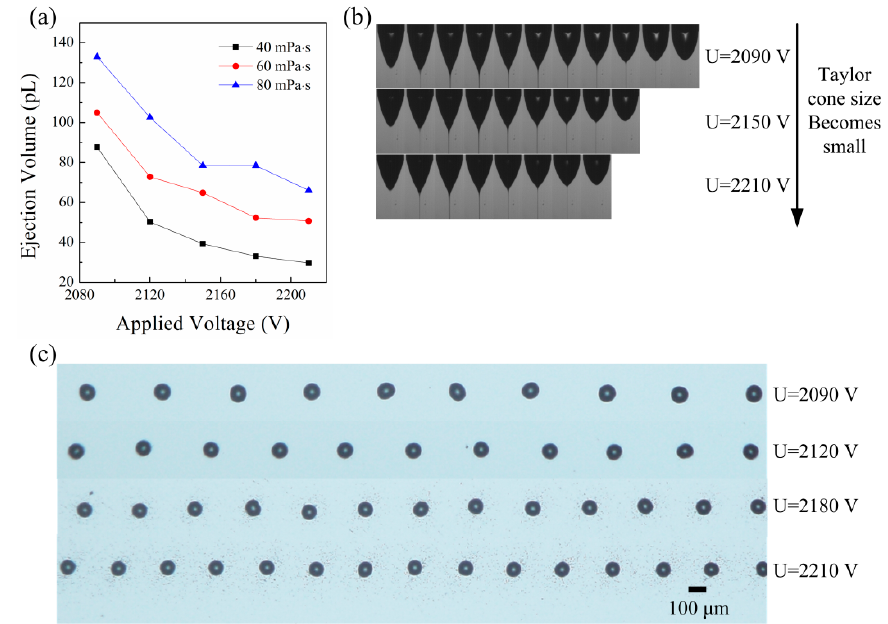
Figure 5. The ejection volume for different applied voltages: ( a ) the relation of the ejection volume with the applied voltage; ( b ) the images of the ejection process for different applied voltages; ( c ) the printed droplets on the silicon wafer for different applied voltages. The viscosity of the liquid for ( b ) and ( c ) was 60 mPa·s. The conductivity of the liquids was 6 µS/cm. The nozzle-to-substrate distance was 1.5 mm. The moving speed of the substrate was 20 mm/s.